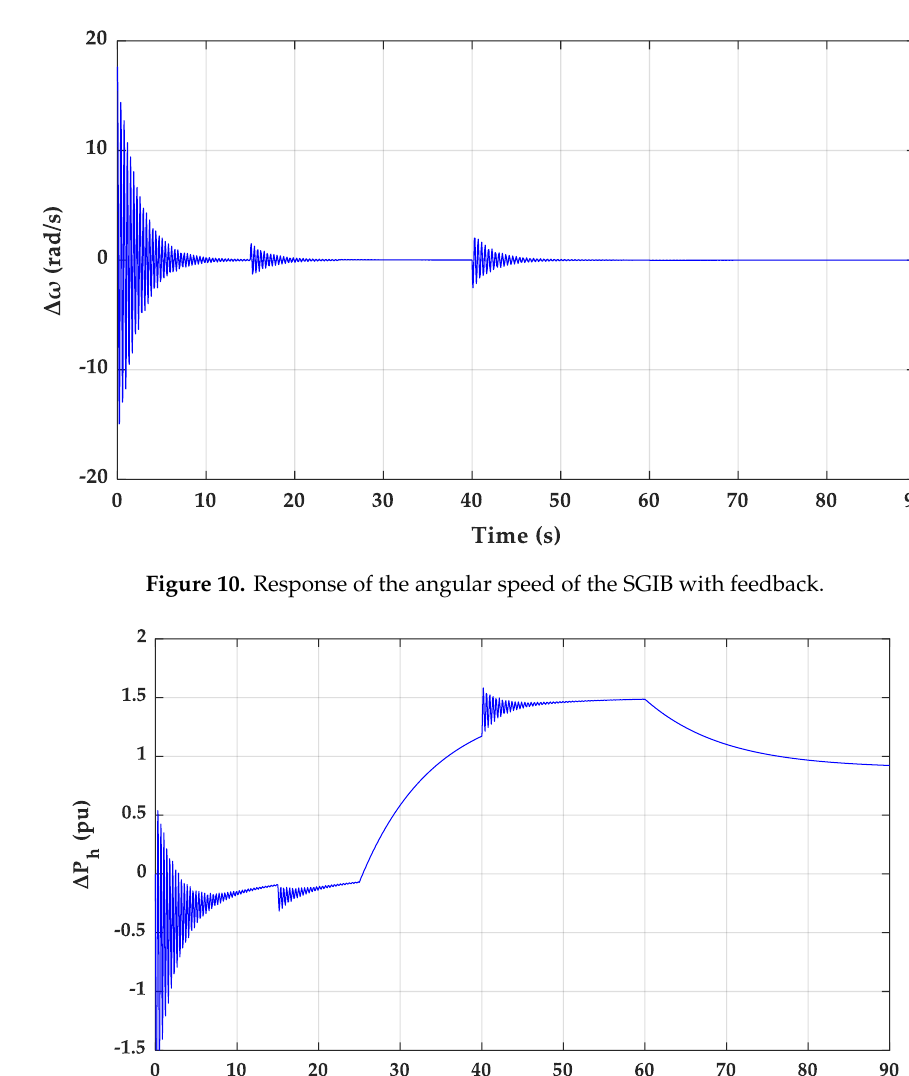
Figure 9. Angle response of the SGIB with feedback.